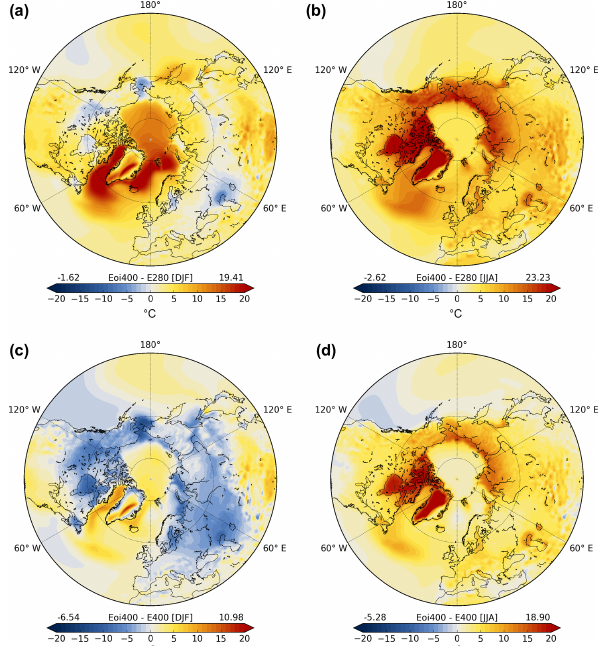
Figure 6. Climatological surface air temperature anomalies for the E oi 400 P mid-Pliocene simulation (cid:104) 2691 , 2720 (cid:105) compared to the preindustrial control E 280 P (cid:104) 5131 , 5160 (cid:105) (a, b) and compared to the modern control E 400 P (cid:104) 1931 , 1960 (cid:105) (c, d) . The (cid:104)(cid:105) denotes the range of model years over which the climatology was computed. Anomaly is defined as Pliocene minus control.